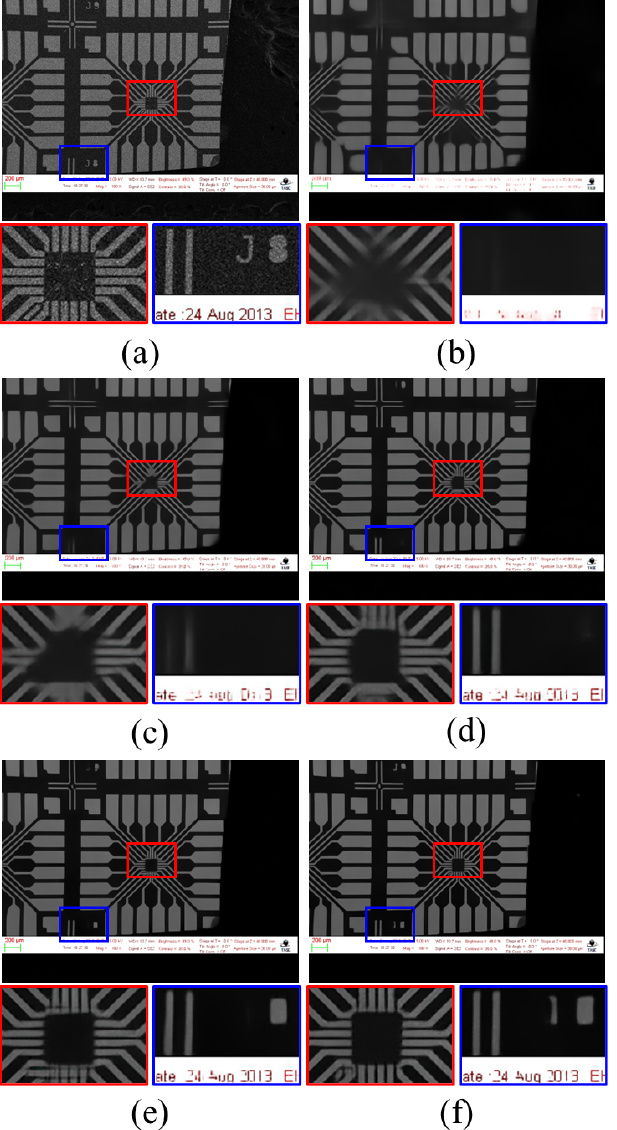
Figure 10. Visual comparison of average denoising by aligned dataset: ( a ) target HR image, ( b – f ) SR result by average denoised LR image using 1, 2, 4, 8, and 16 LR images